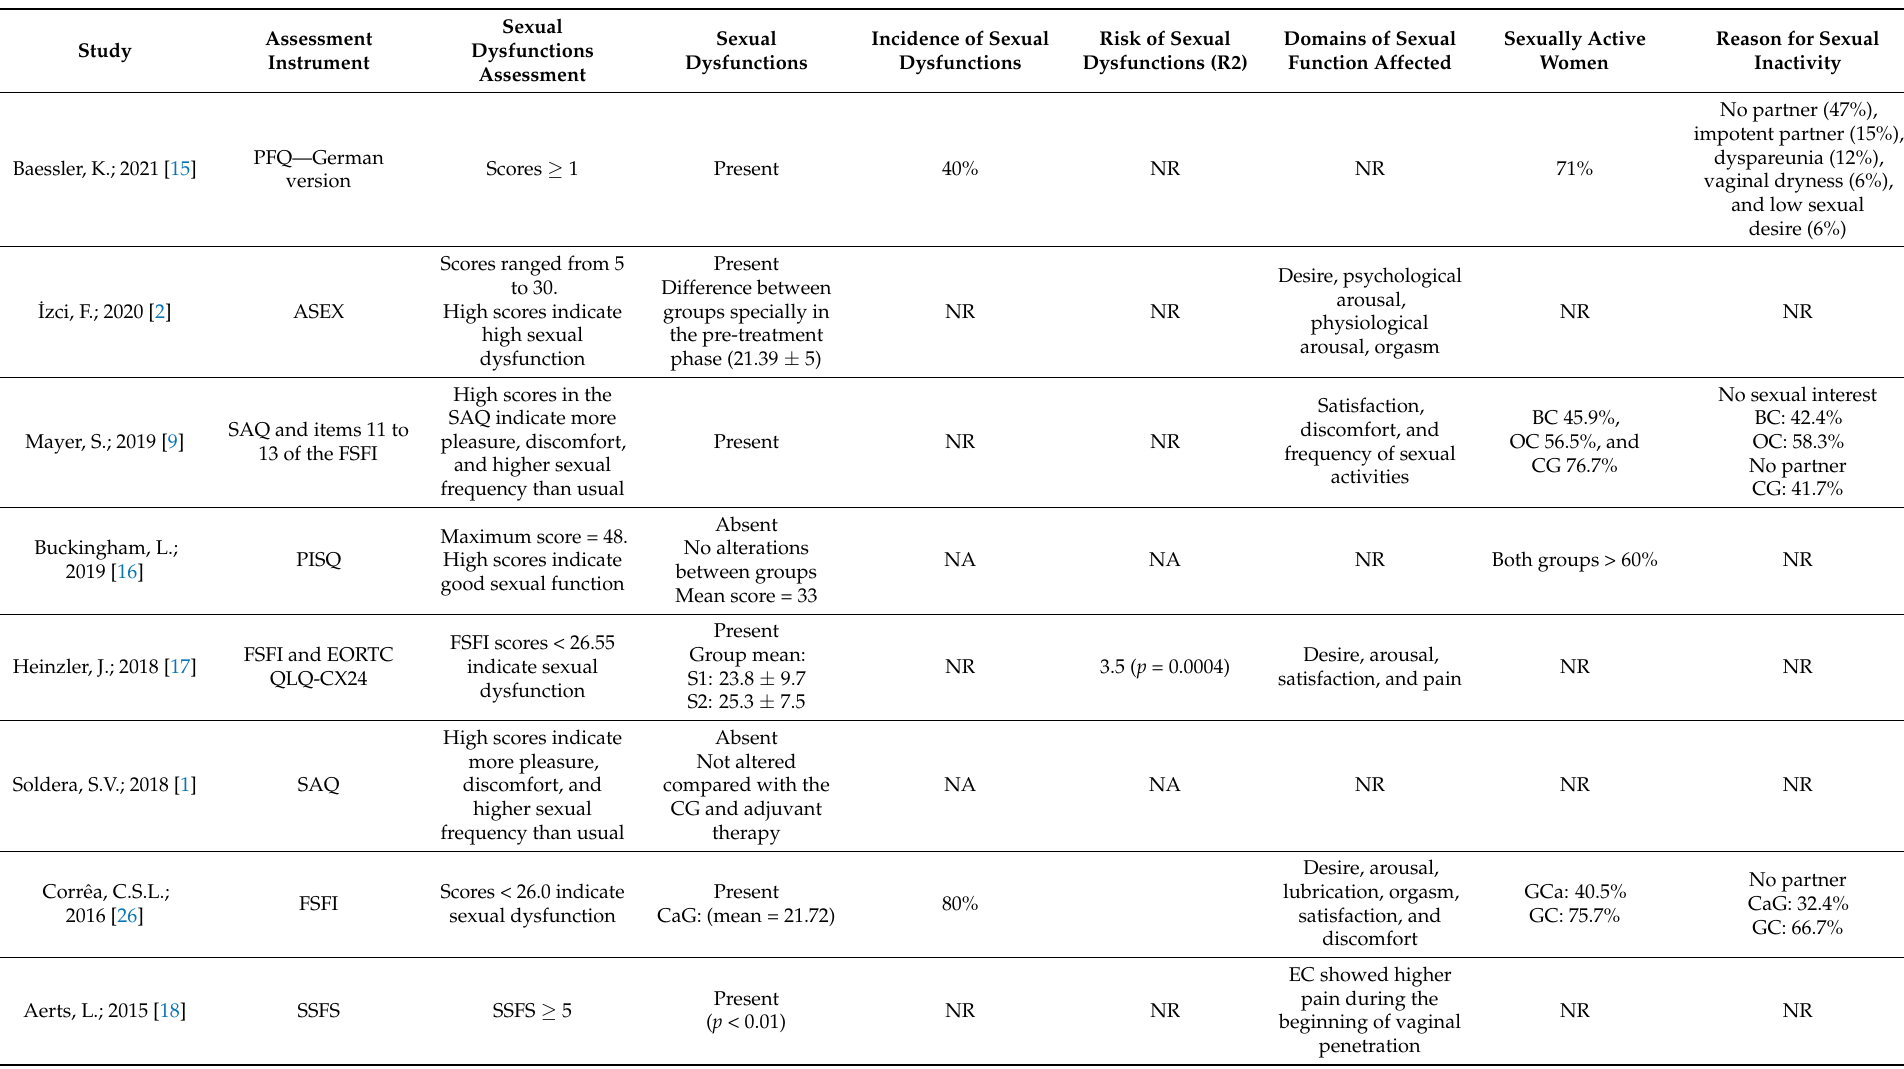
Table 3. Analysis of sexual dysfunction and